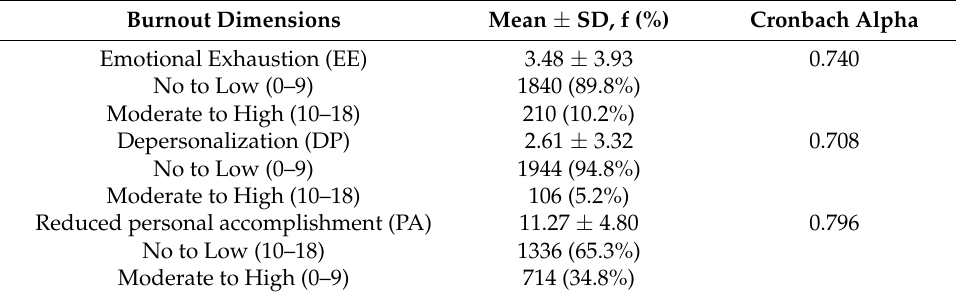
Table 4. Categorization of the levels of